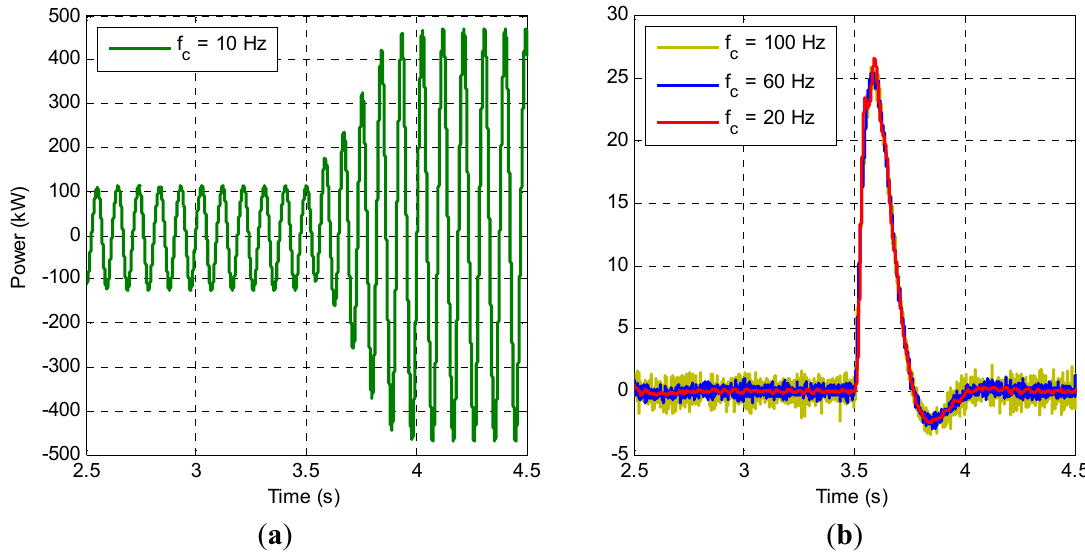
Figure 9. Effect of the cut-off frequency of the low-pass filter in the error of the active power control.